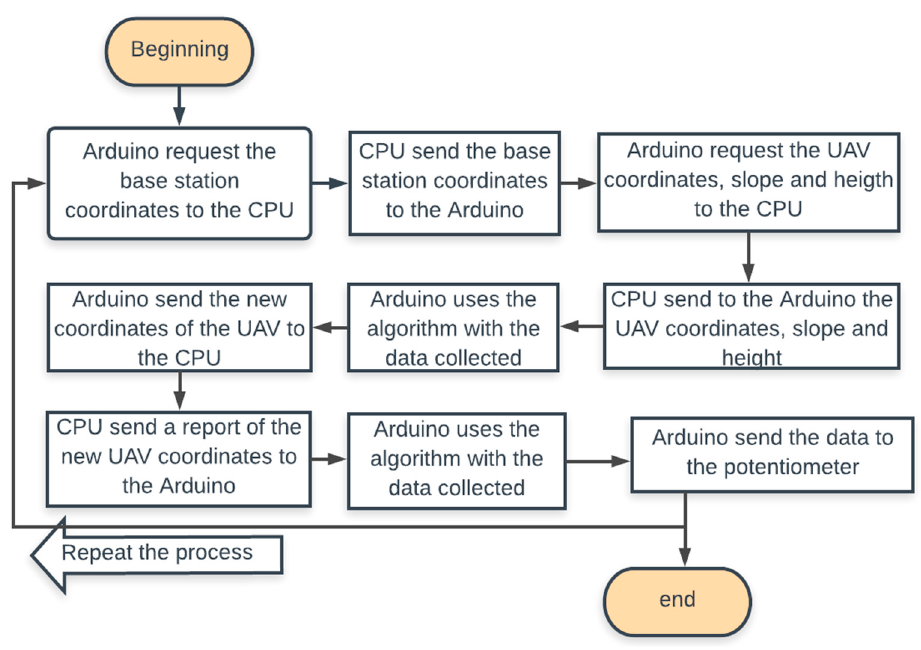
Figure 17. Flowchart of the process.